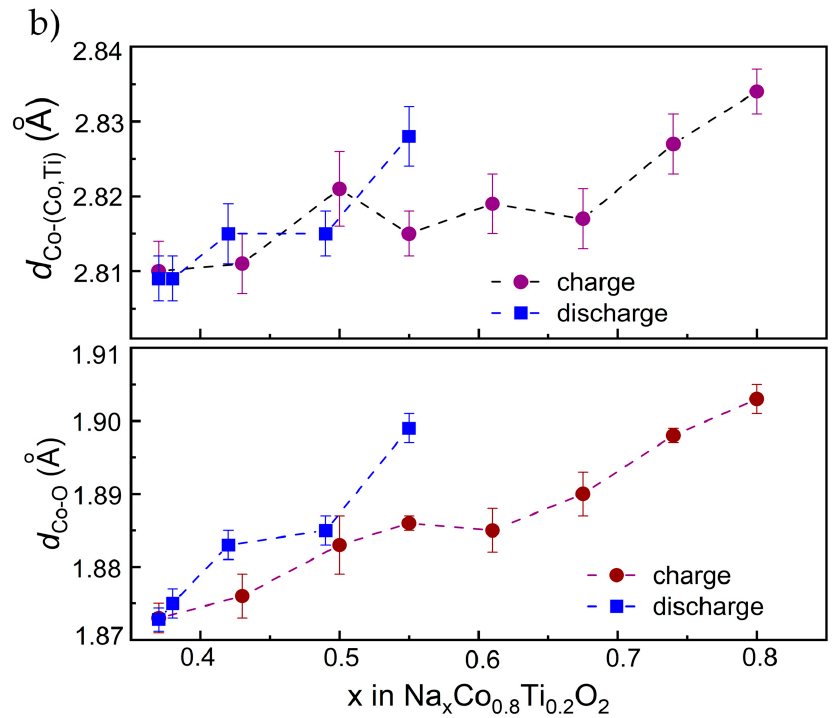
Figure 7. ( a ) X-ray absorption near edge structure (XANES) at the Co-K edge during charge of Na 0.8 Co 0.8 Ti 0.2 O 2 , together with the spectra of reference materials CoO, Co 3 O 4 and Co(AcAc) 3 . ( b ) Changes in Co-(Co,Ti) and Co-O interatomic distances in Na 0.8 Co 0.8 Ti 0.2 O 2 upon Na-removal and insertion, evaluated from in situ Co-EXAFS experiments. The coordination spheres up to 3.1 Å were considered for the calculations. Detailed fitting results are given in Table